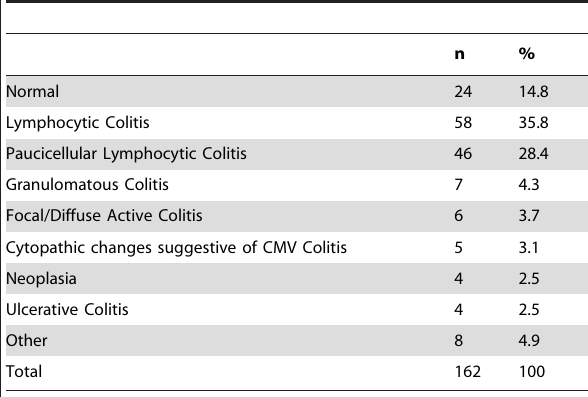
Table 3. Colonic histopathological findings.